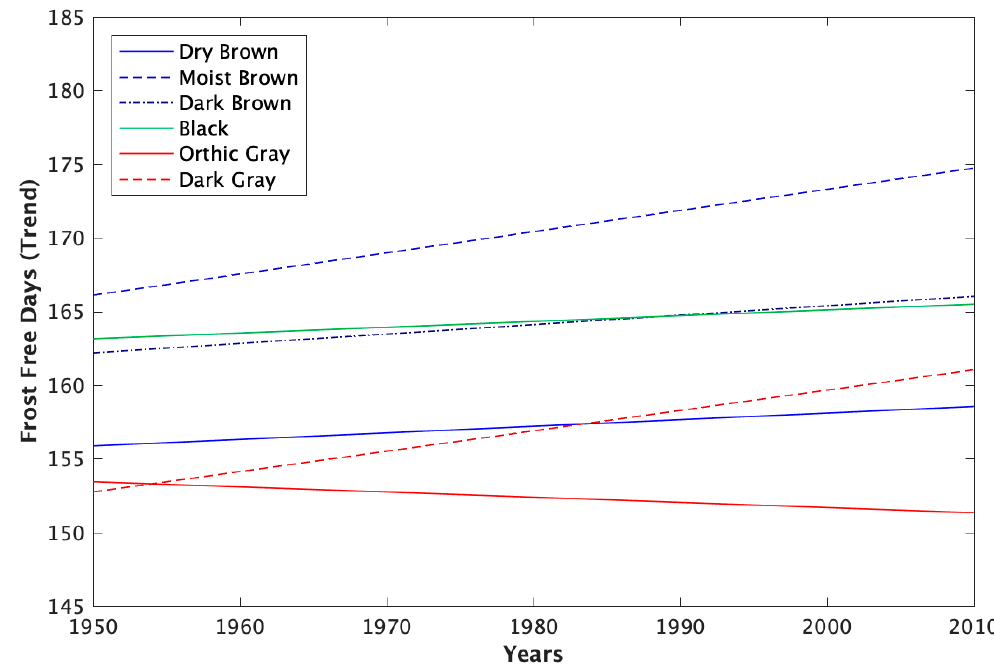
Figure 9. Frost free days (FFDs) trend (1950–2010) for all soil zones.